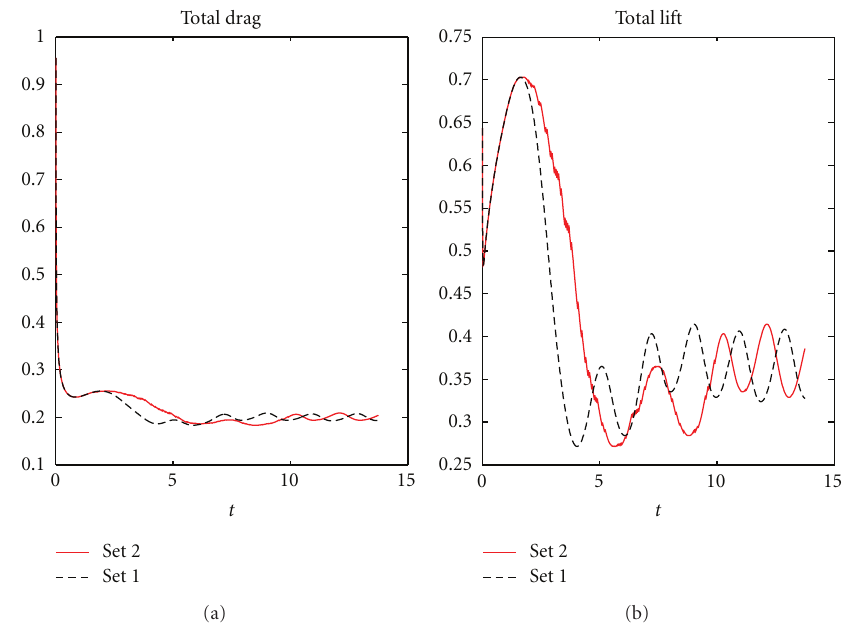
Figure 17: Total drag and total lift when using M = 4 and M = 5.